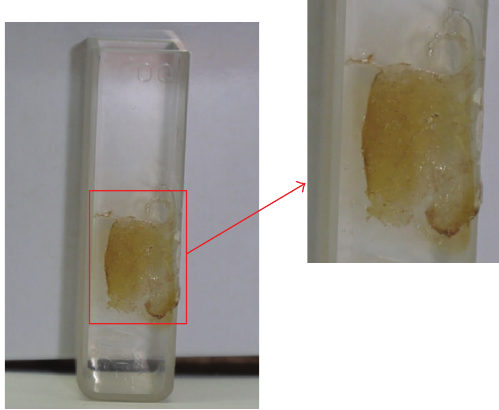
Figure 11: Quartz tube attached with PVA yarn with nanosilver colloid.